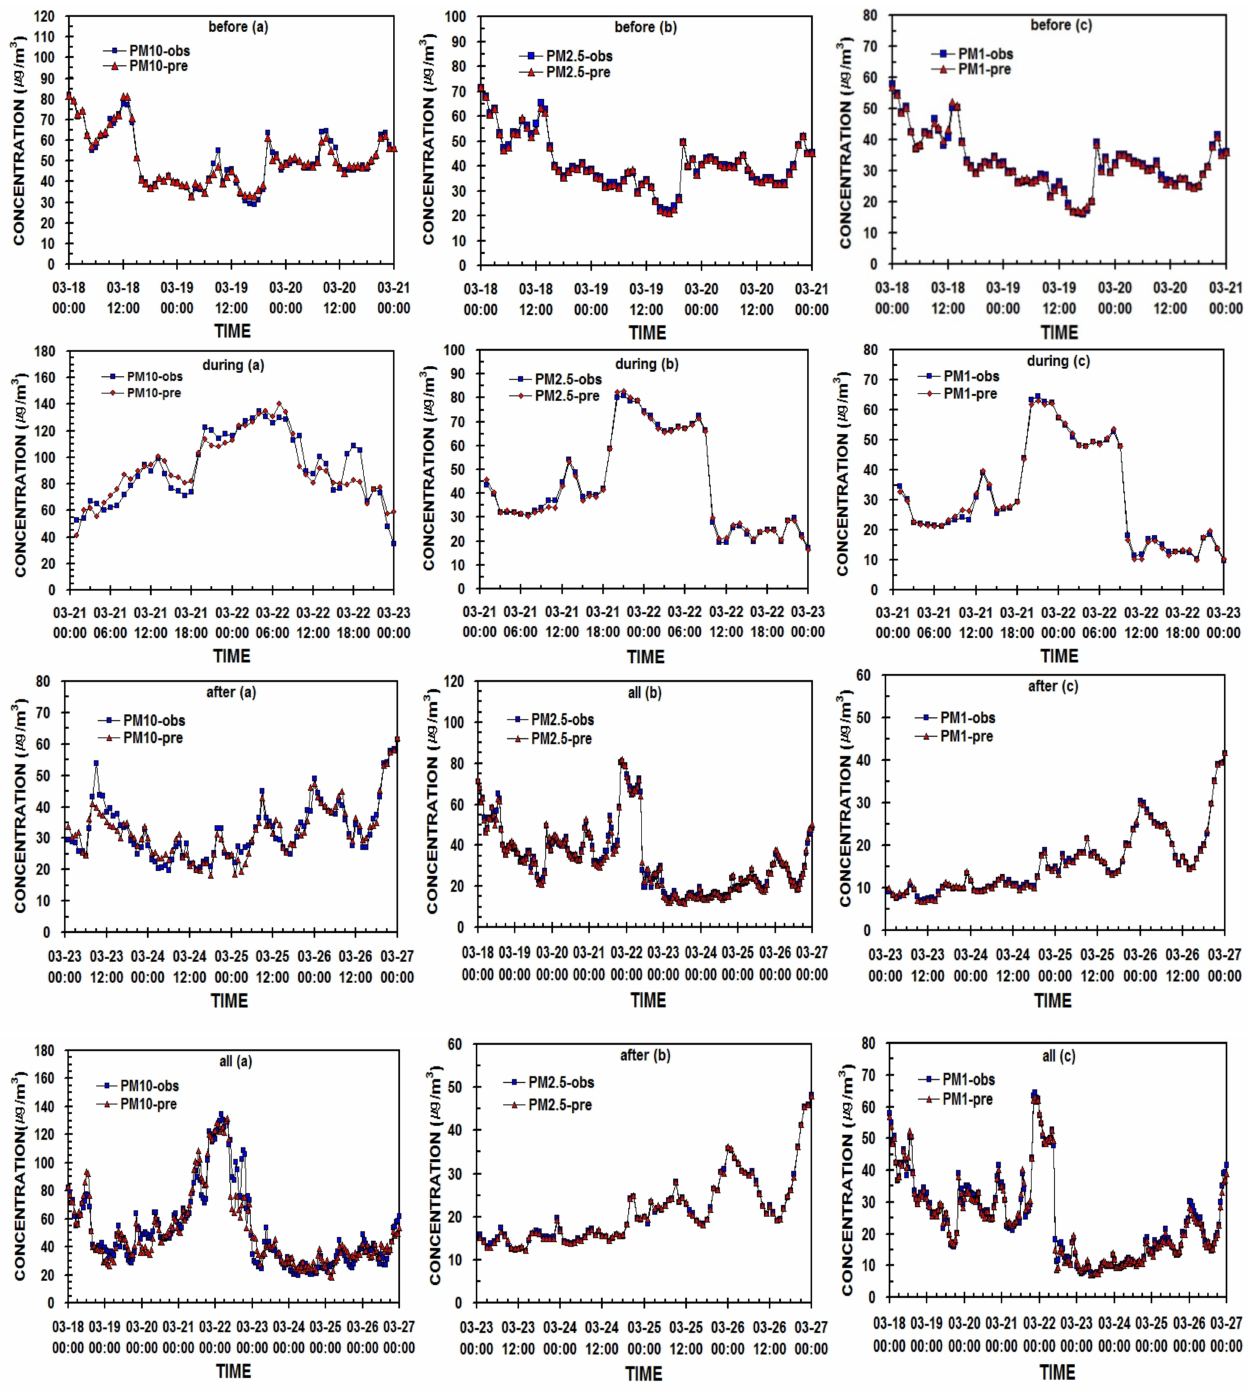
Figure 7. The comparison of observed vs. calculated PM 10 , PM 2.5 and PM 1 values with date in ( a – c ) figures through model fitting, before, during, after the dust periods and all periods from 18 to 27 March, 2015 in Gangneung city,